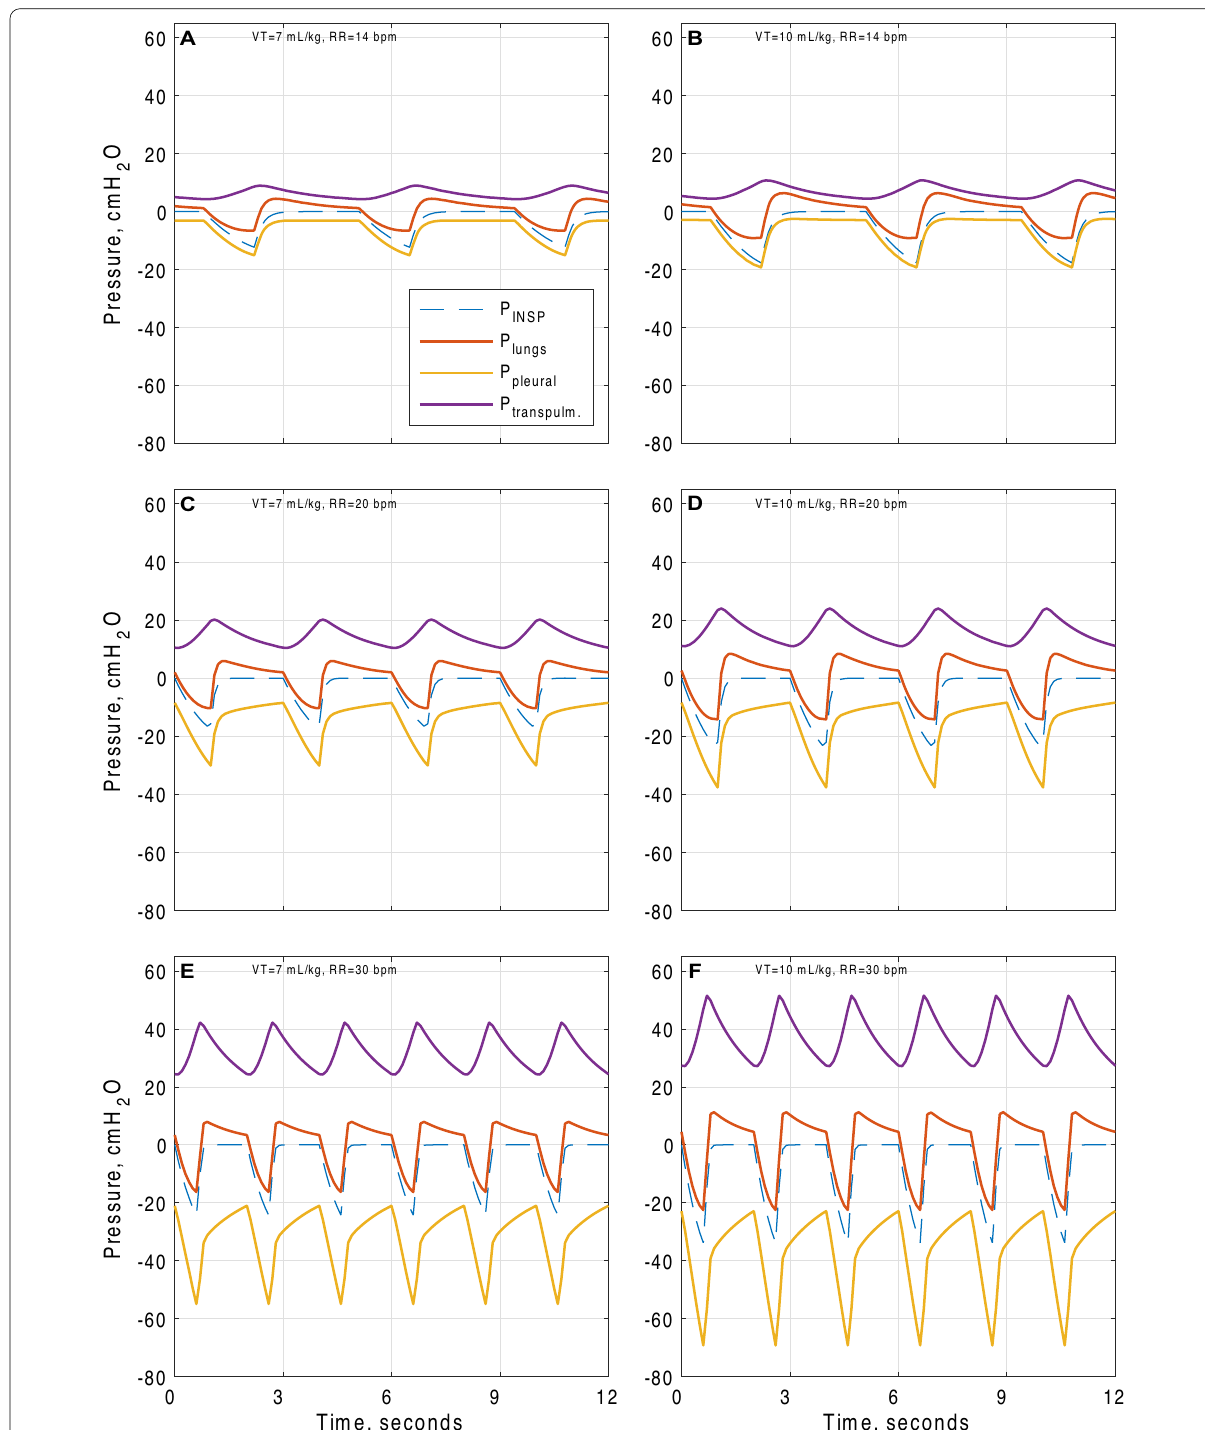
Fig. 1 Inspiratory, pleural, transpulmonary and alveolar pressure swings generated by normal and increased respiratory effort in our COVID-19 model (patient 1—see Additional file 1: Table S3), A VT VT 10 ml/kg, RR 20 b/min, E VT = =